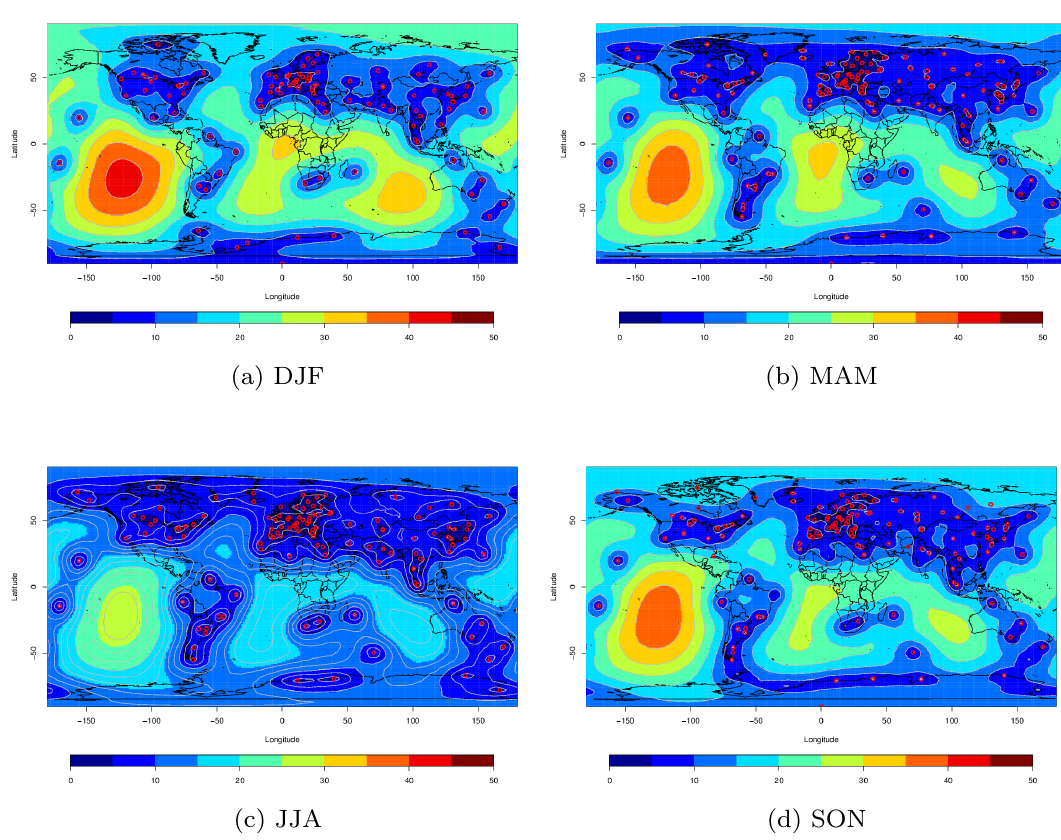
Figure 3. Surface predicted ozone (DU) standard deviation from SPDE approach (strategy D) by season from 2000.